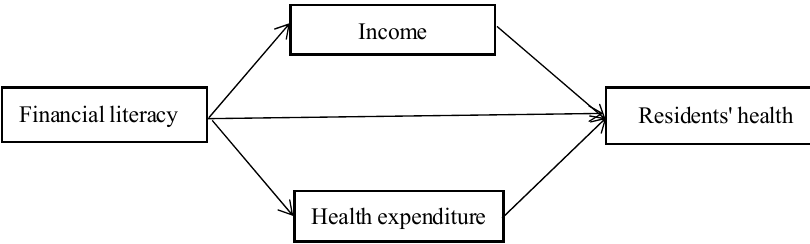
Figure 1. The mechanism of financial literacy affecting residents‘ health.